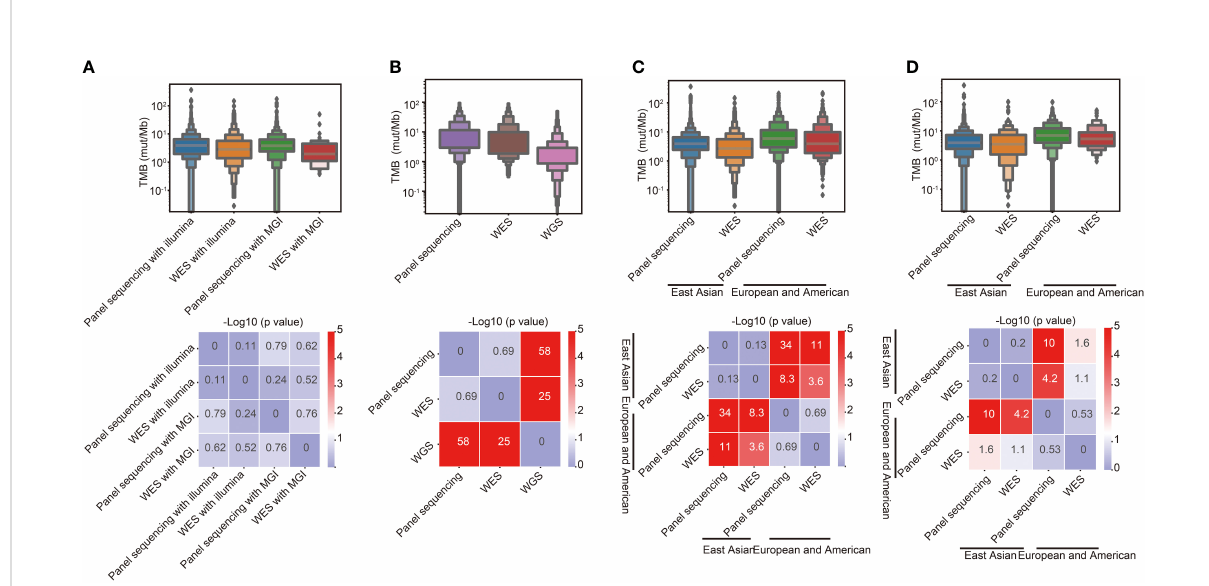
FIGURE 1 Effects of different sequencing platforms, sequencing methods and races on TMB. (A) Comparison of TMB between different sequencing platforms and methods in East Asian populations. (B) Comparison of TMB between different sequencing methods in European and American populations. (C) Comparison of TMB between different racial groups. (D) Comparison of TMB between different racial groups in lung